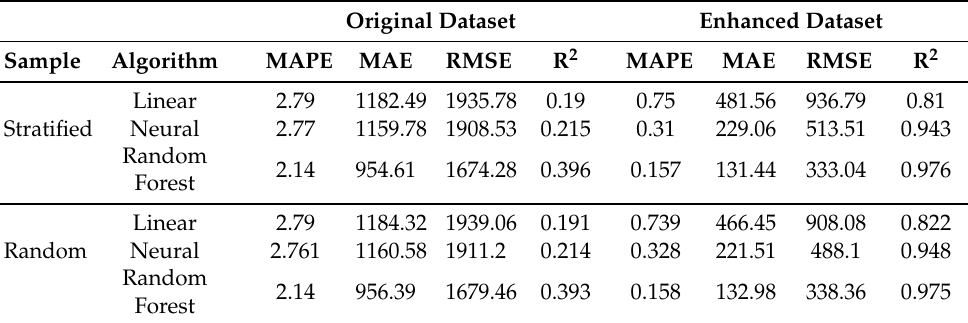
Table 5. Evaluation metrics of the trained machine learning models on both the original and en- hanced dataset.